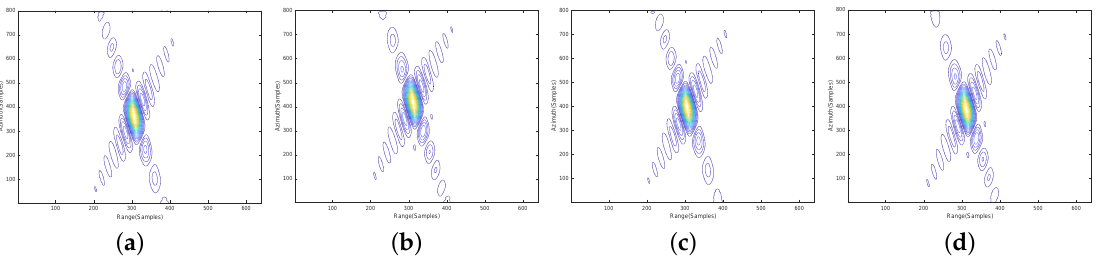
Figure 10. Imaging results of the proposed algorithm. ( a ) P 1 . ( b ) P 2 . ( c ) P 3 . ( d ) P 4